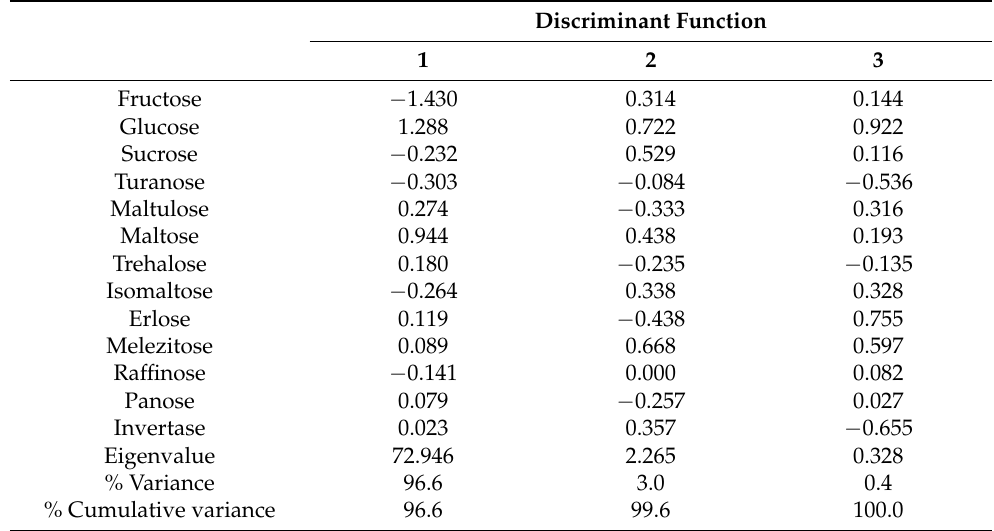
Table 4. Percentages of variance, cumulative and cumulative variance and discriminant functions as derived from the multi-discriminant analysis